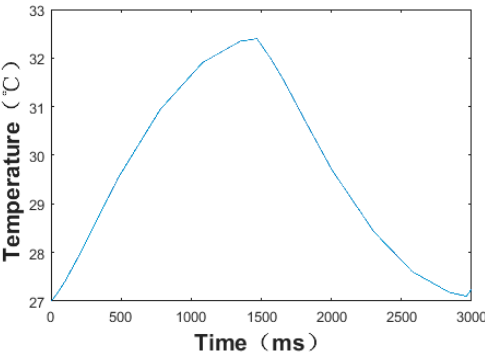
Figure 17. Simulation curve of thermocouple junction end temperature change under normal respiration conditions.